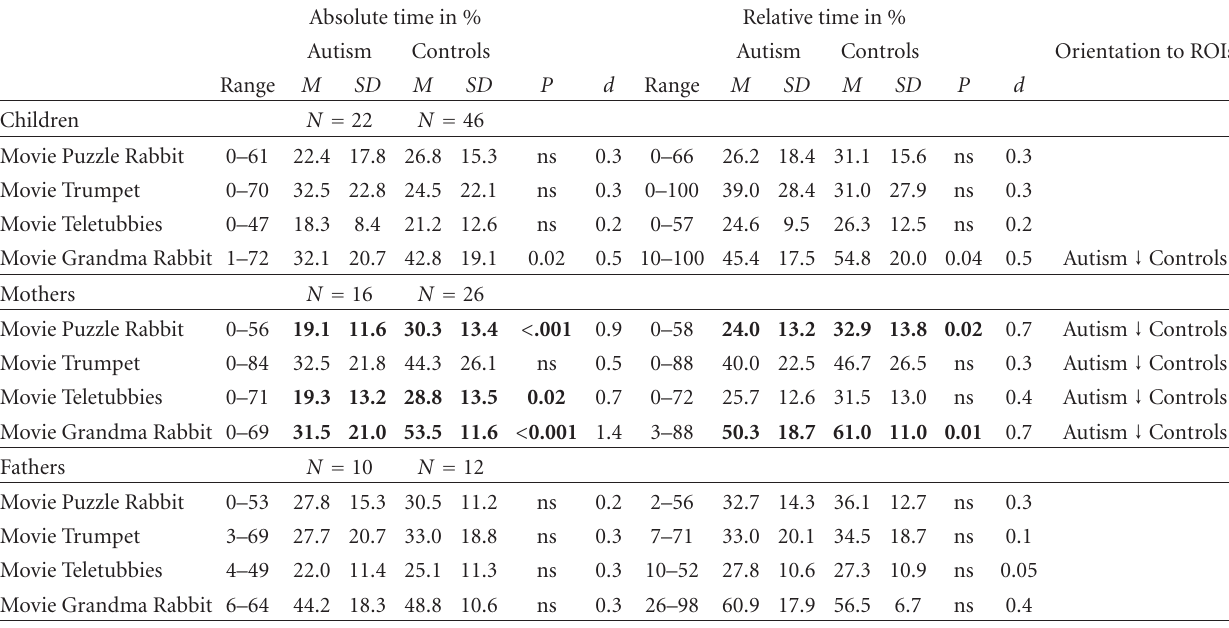
Table 3: Percentage of absolute and relative time watched at regions of interest (ROIs) in children with ASD and control children and their fathers and